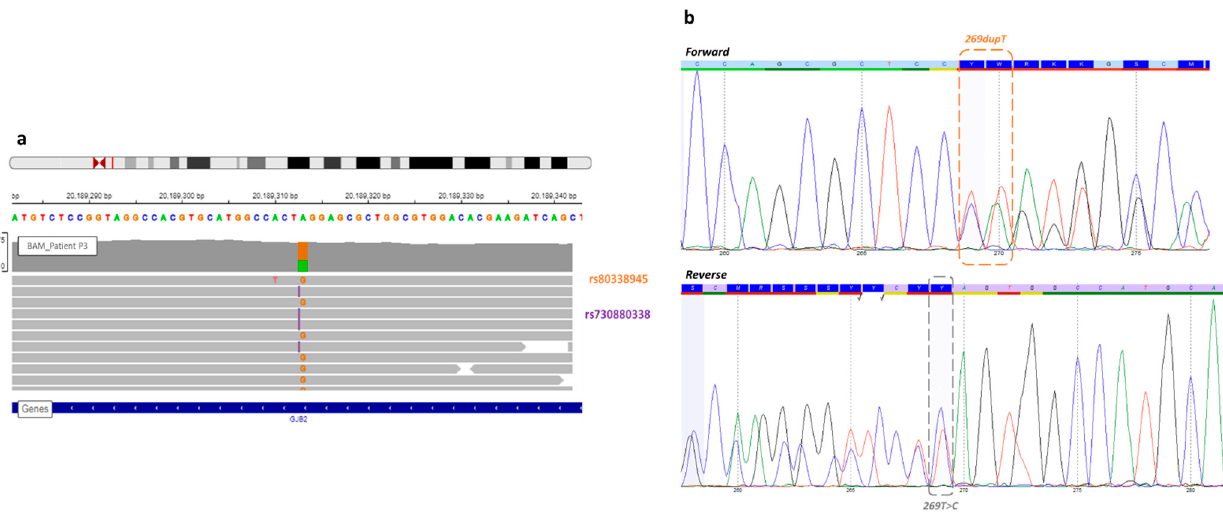
Figure 1. View of the missense variant and frameshift GJB2 gene of patient P3. ( a ) In the Integrative Genome Viewer, the frameshift variant (rs730880338) at c.269 GJB2 position, known before WGS (orange), and the missense variant (rs80338945) discovered by WGS analysis (purple). Each variant was on a different read, so this analysis confirmed a trans configuration. ( b ) A new Sanger sequencing in forward and reverse detected both mutations, but it still remains difficult to interpret.